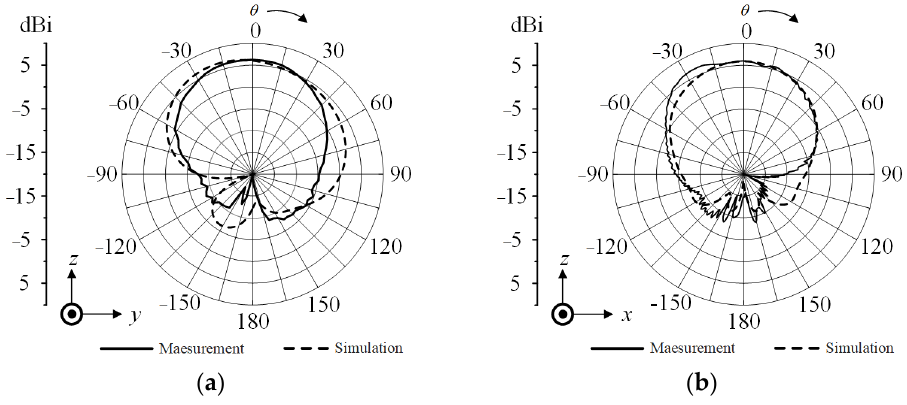
Figure 5. 2D radiation patterns: ( a ) at 3.25 GHz; ( b ) at 9.5 GHz.